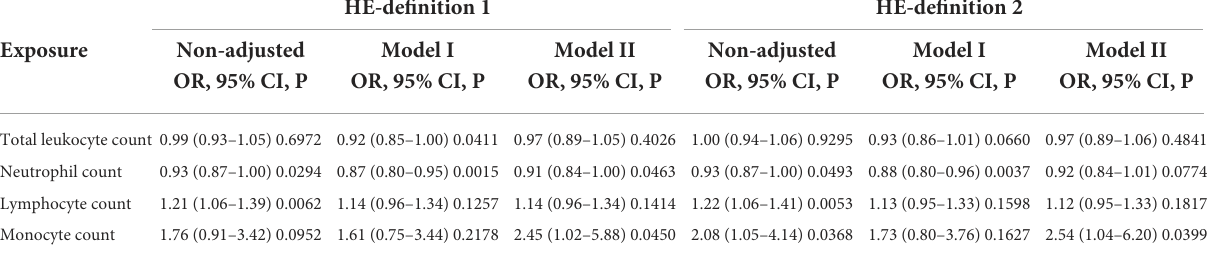
TABLE 3 Binary logistic regression of the relationship of leukocytes and their subpopulations with hematoma expansion (HE) based on two definitions.